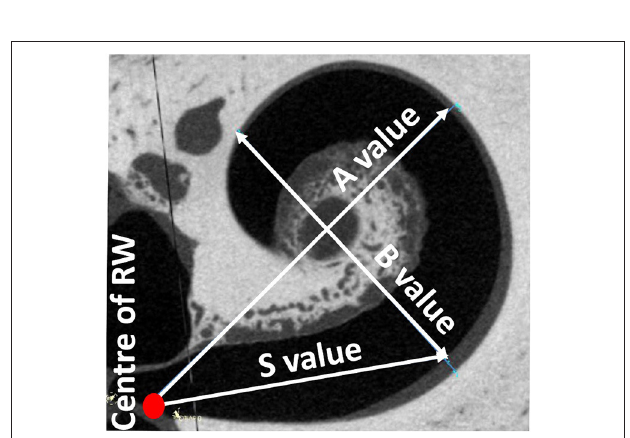
FIGURE 2 | Oblique coronal plane through the basal turn with the cochlear parameters